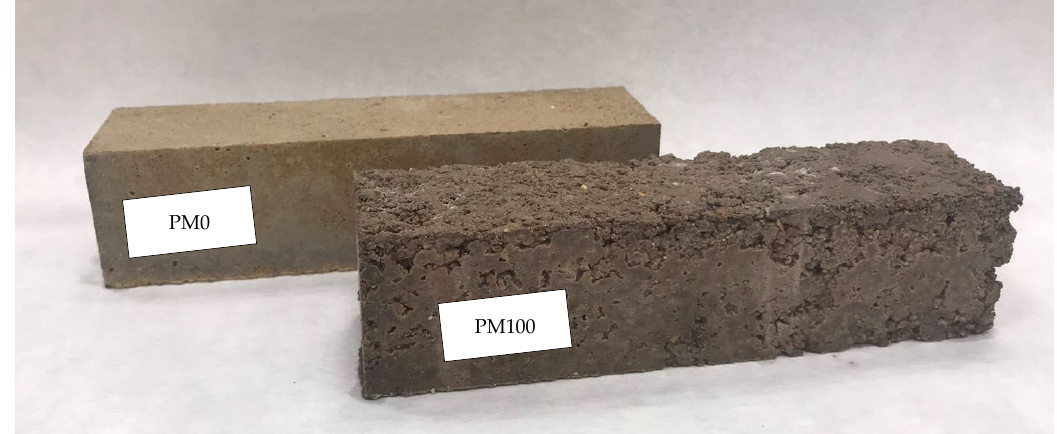
Figure 1. Porous appearance of PM100 versus smooth appearance of other mixes.